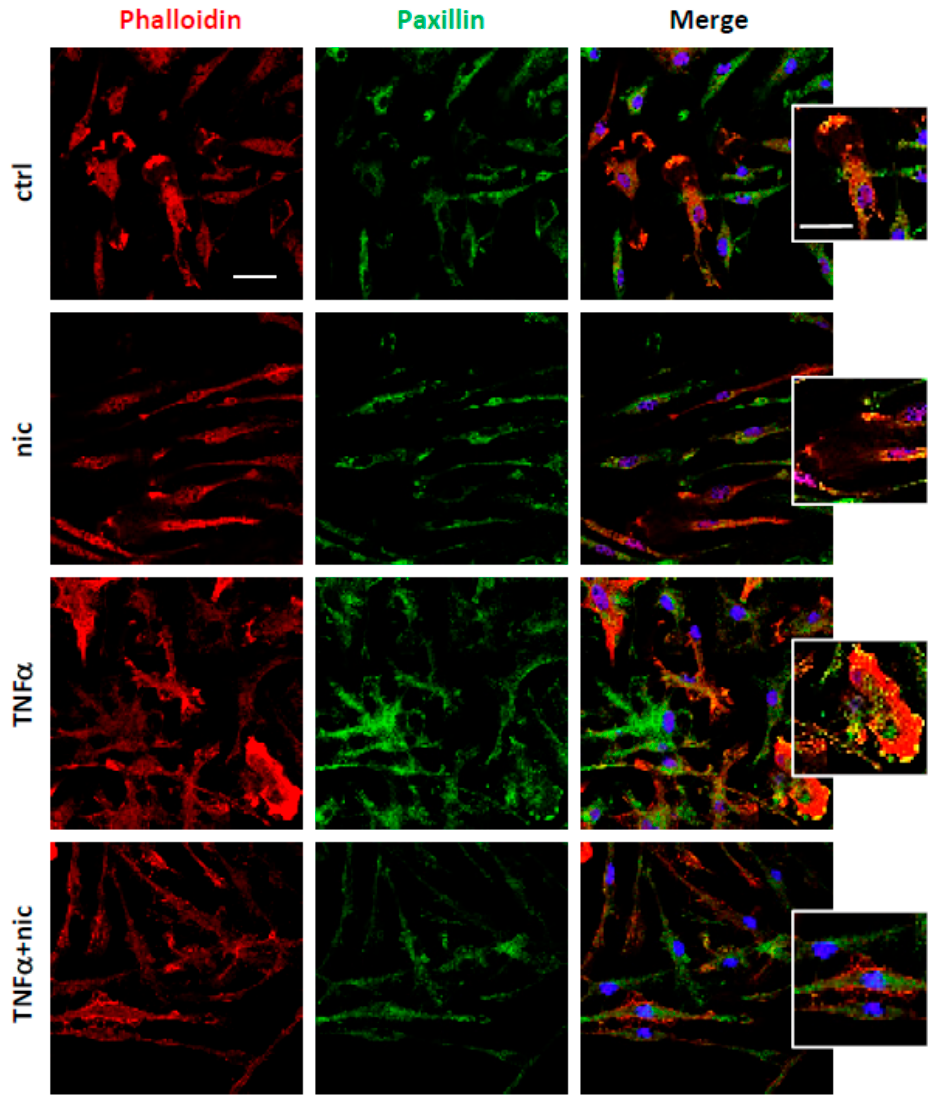
Figure 2. Niclosamide promotes the resting phenotype in tumor necrosis factor-alpha (TNF α )-stimulated microglia. Double immunofluorescence with phalloidin (red) and paxillin (green) on cells treated with DMSO (ctrl) or 100 nM niclosamide (nic) for 72 h. The stimulation with 50 ng / mL TNF α was induced after 24 h from DMSO or niclosamide pre-treatment and left for the following 48 h. In merge images, the nuclei were stained with DAPI. Scale bar: 20 µ m. Higher magnification images show lamellipodia. Scale bar: 20 µ m.